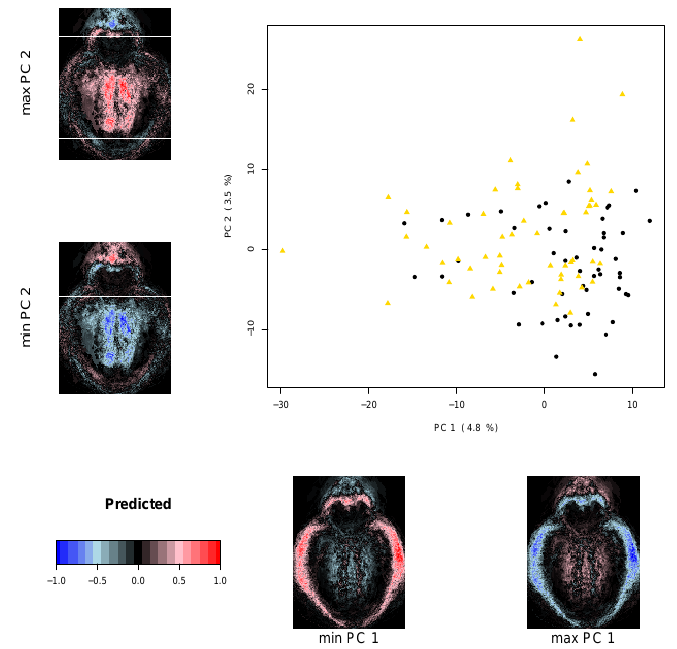
Figure 5. Two first axes of principal component analysis (PCA) performed on pixel matrix for cluster 6 (light brown colour, RGB: 141, 132, 109) suggested that O. a. subsp. aveyronensis and O. aveyronensis subsp. vitorica differentiate phenotypically based on the presence or absence of labellum marginal pilosity (gold: O. aveyronensis subsp. vitorica , black: O. a. subsp. aveyronensis ). Pixel matrix for cluster 6 was provided by R package patternize using k -means clustering transformation ( k =